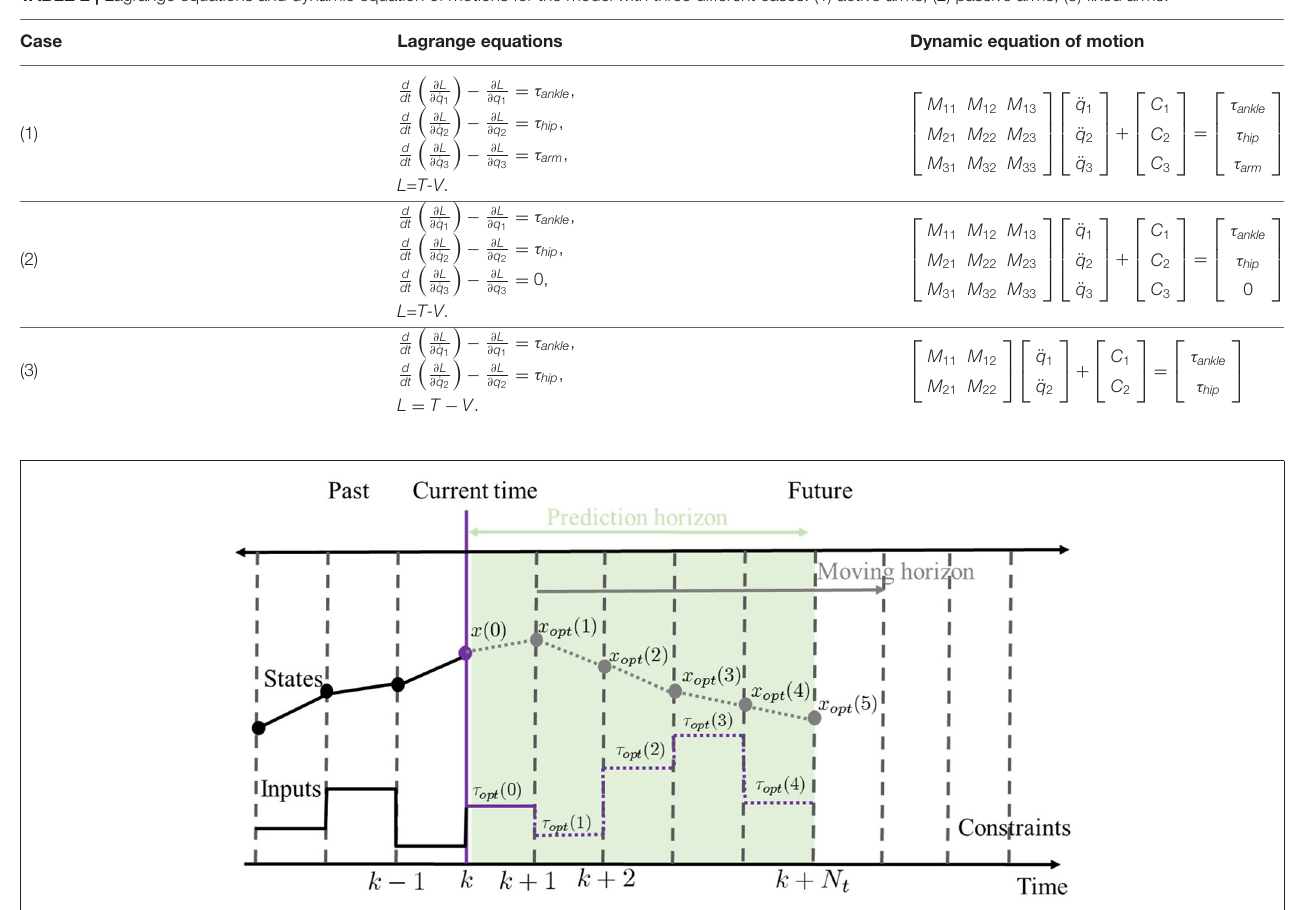
FIGURE 2 | Schematic description of the NMPC at time k . The proposed dynamic model is recruited to predict the future motion state sequence x opt of the model system and compute optimal control input sequence τ opt of balance recovery based on the current state through solving an optimization problem. For instance, let NMPC starts at k = 0 with a prediction horizon N t (here N t = 5) and the initial states x (0).